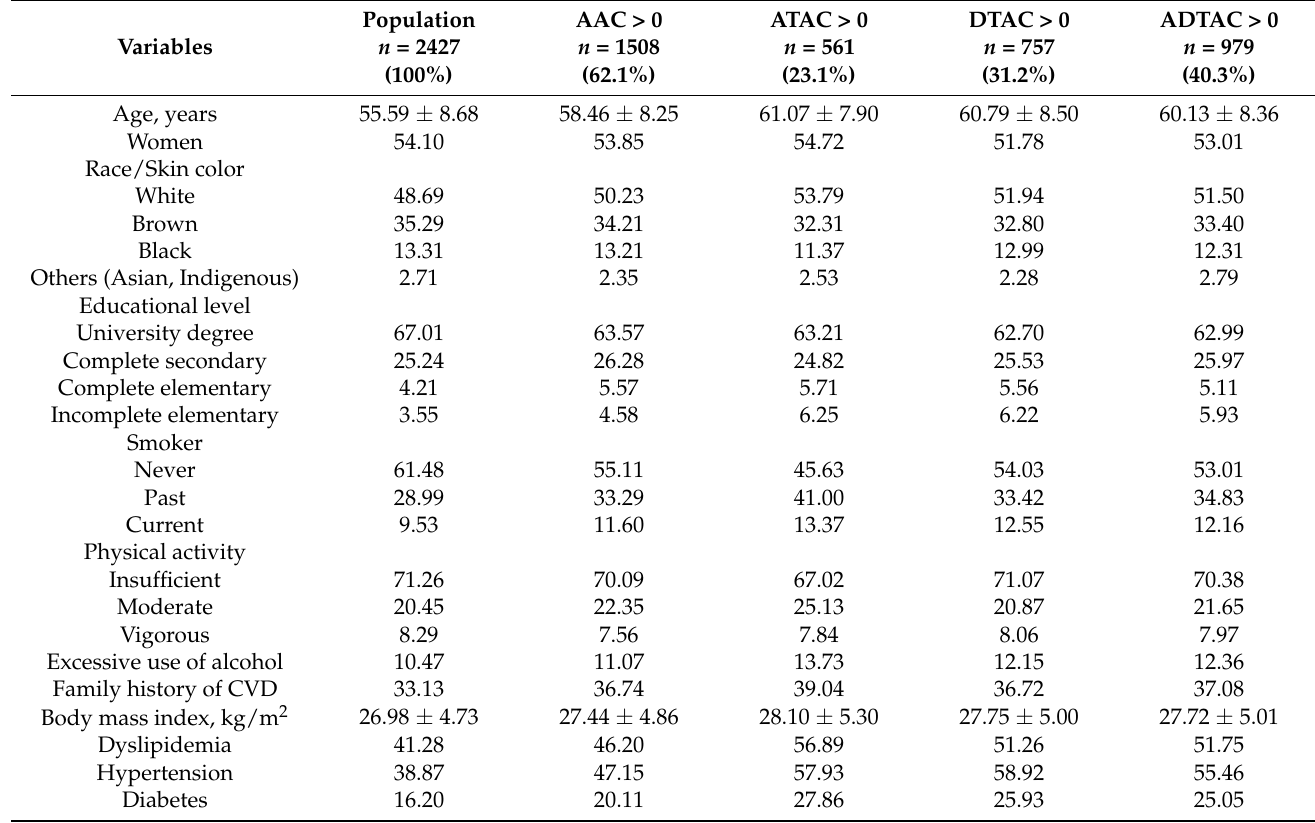
Table 1. Characteristics of study population and prevalence of calcium in the aortic arch, ascending aorta, descending thoracic aorta and in combination of calcium in the ascending and descending thoracic aortic segments (ELSA-Brasil,